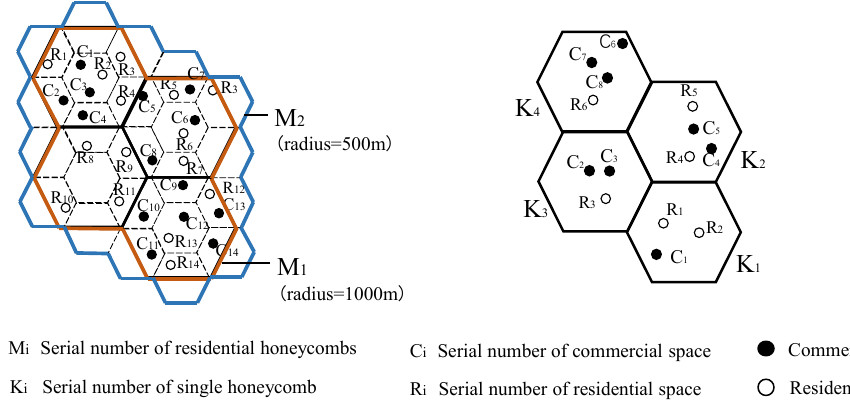
Figure 3. Indicator description of the honeycomb grid analysis ( a , b ).